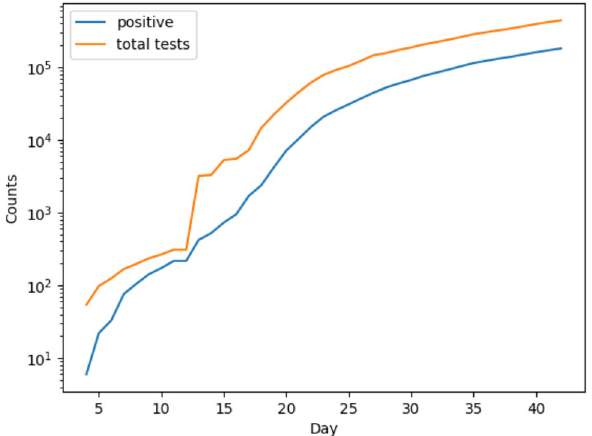
Figure 2. Levels of total testing and positive cases identified in New York